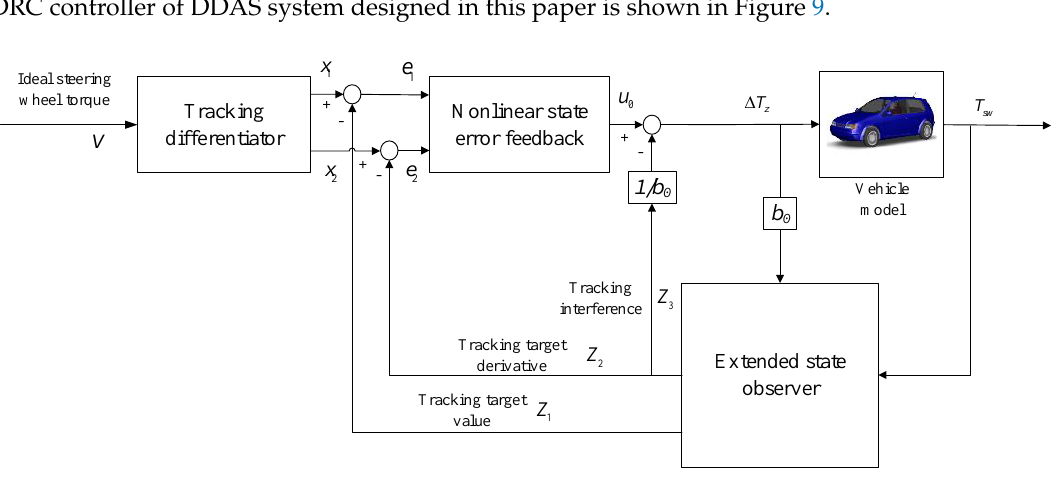
Figure 9. The structure of ADRC controller of DDAS system.